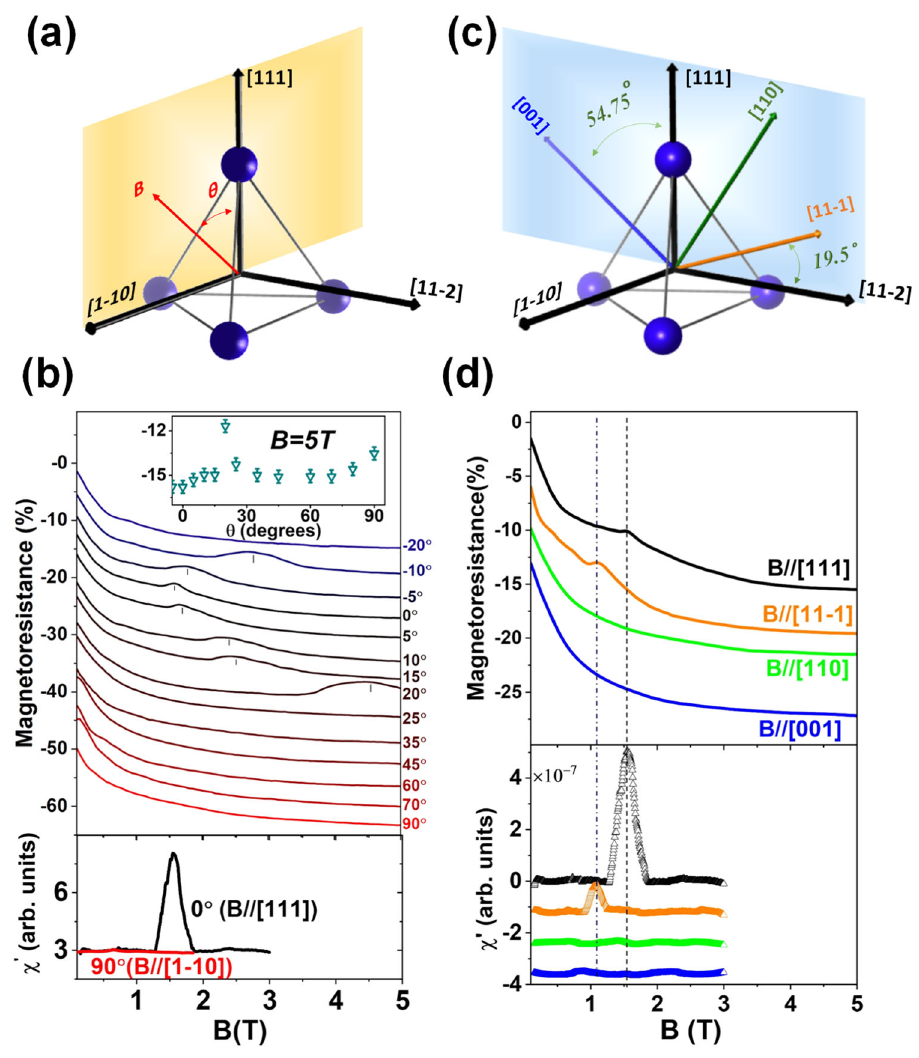
Fig. 2 | Magnetoresistance anomaly. a Geometric diagram of the MR measure- illustrates the MR at each angle when B =5T. c Geometric diagram of the MR measurement with B in the (1-10) plane, which contains four high-symmetry axes. ment with B in the (11-2) plane, where θ is the fi eld angle respected to the [111] d MR (top)and ACsusceptibility(bottom)at0.03K along the high-symmetryaxes ×100%, where R 0 is the zero- fi eld resis- direction. MR is de fi ned as MR= R B ð Þ(cid:2) R 0 R 0 in this geometry. Vertical offsets are applied on the curves for tance. b MR(top)and ACsusceptibility (bottom)at0.03K atselected angles;inset